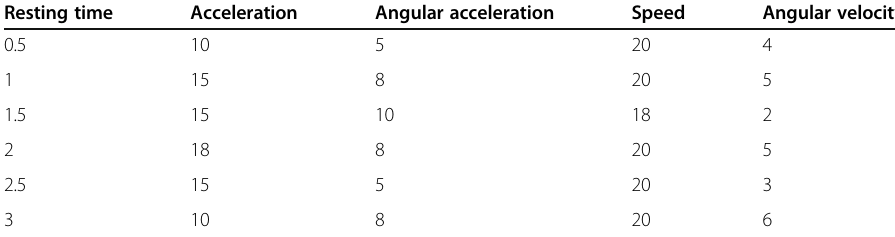
Table 1 Dynamic test